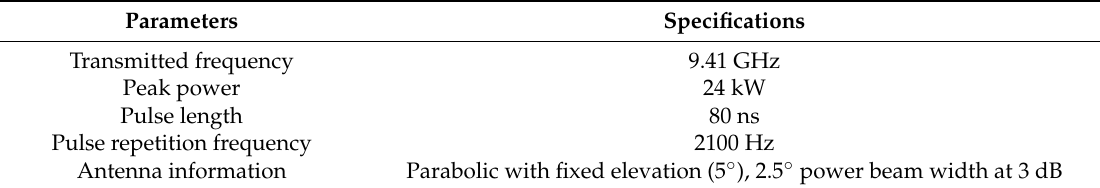
Table 1. The technical characteristics of the LaMP X-band radar.